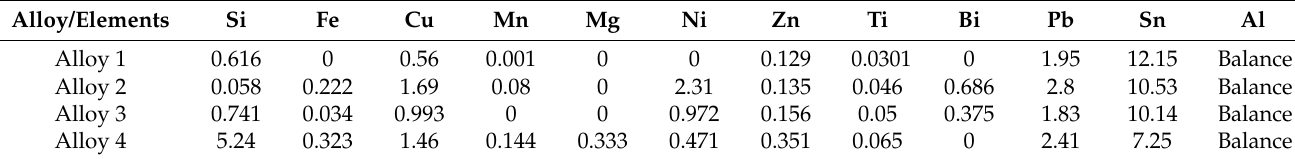
Table 8. Chemical composition of the verification alloys.